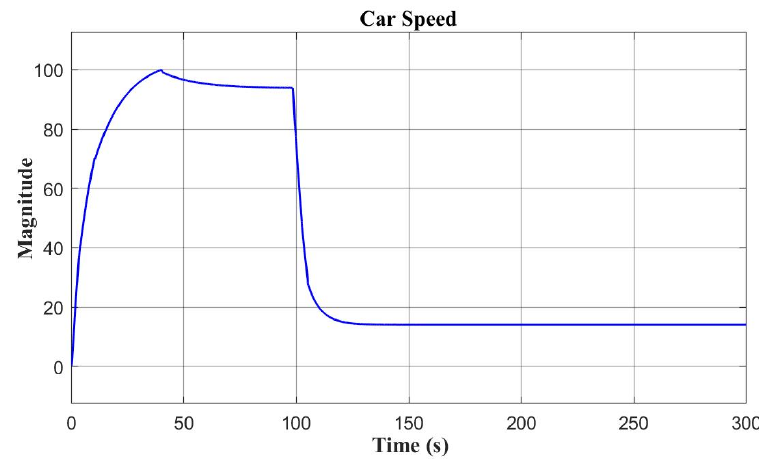
Figure 12. Autonomous vehicle speed after fault injection in Wheel 1.